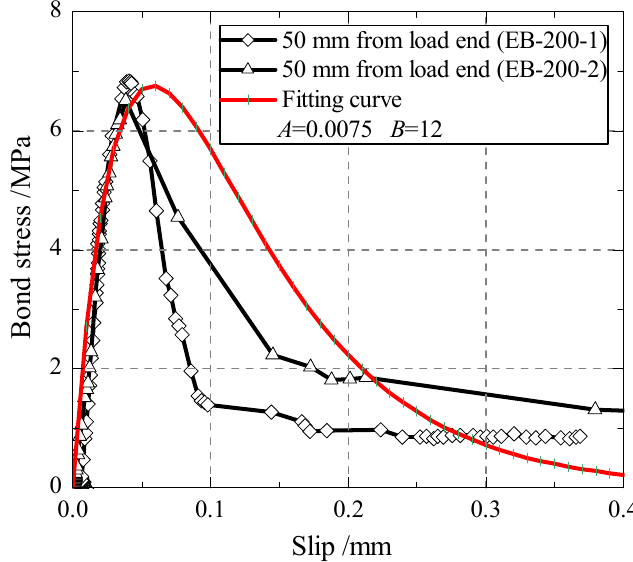
Figure 9. bond-slip constitutive model. Figure 9. Bond-slip constitutive